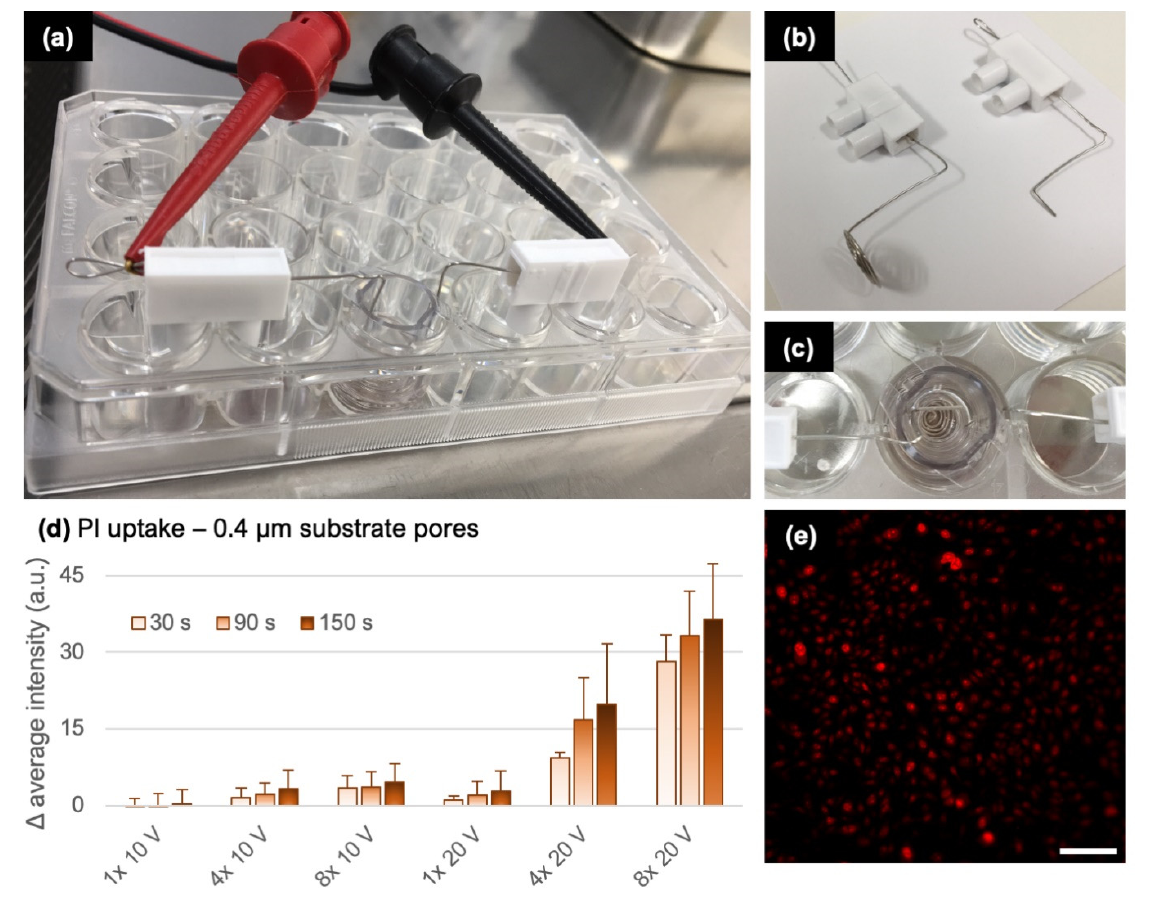
Figure 4. Final experimental configuration and testing. ( a ) Images of the 24-well plate containing an insert and wire electrodes. ( b ) Wire electrodes. ( c ) Insert positioned in the 24-well plate, viewed from top. ( d ) PI intracellular uptake detected by increase in the average sample fluorescence. Bars with different shades show the change in fluorescence at indicated time points after delivery of 10-ms-long pulses. The pulse number and amplitude are indicated at the x -axis. Graph shows the mean and range from two experiments. ( e ) Fluorescence image of cells stained with PI upon exposure to 4 × 10 ms, 20 V pulses. Scalebar 100 µm.